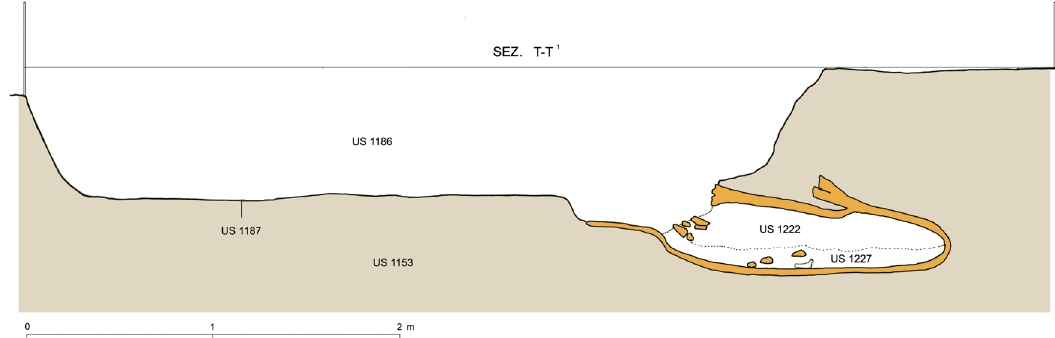
Figure 3: Portonovo ( Marche, Italy ) . Cross section of oven 23 and its access pit US